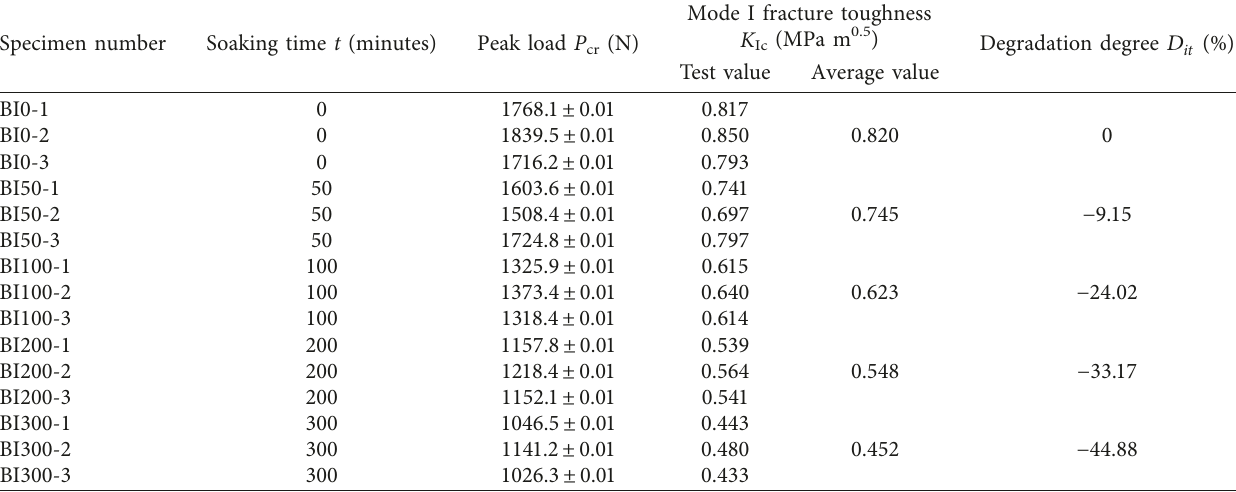
Table 3: Mode I fracture toughness of Type B mudstone specimens for different soaking times.